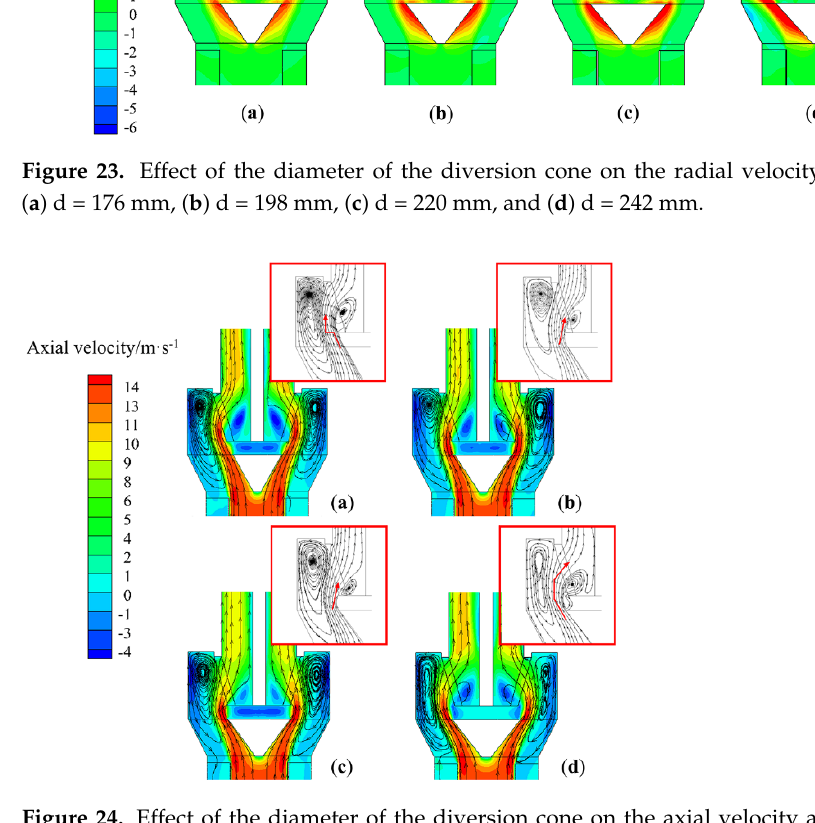
Figure 25. Effect of the diameter of the diversion cone on the radial velocity (T-D (1-0.7) , x = 0): ( a ) d = 154 mm, ( b ) d = 173.3 mm, ( c ) d = 192.5 mm, and ( d ) d = 211.7 mm. The discrete phase model was used to simulate the classifying motion of particles in classifiers with different diameter diversion cones. Nineteen groups of particles were se- lected between 0 and 75 μ m. Each group tracked 758 particles in order to simulate the particle trajectory. The Tromp curve is shown in Figure 26. As the diversion cone diameter increased, the cut size decreased and subsequently increased. Furthermore, the sharpness of separation increased and then decreased. When the diversion-cone diameter to rotor- cage-chassis diameter ratio is 1.0:1.0 or 1.0:0.9, the cut size and sharpness of separation are approximated, and the dynamic classifier has the best classification effect. Figure 26. Tromp curves for different diameter diversion cone classifiers: ( a ) T-C (1-0.8) and ( b ) T-D (1- 0.7).